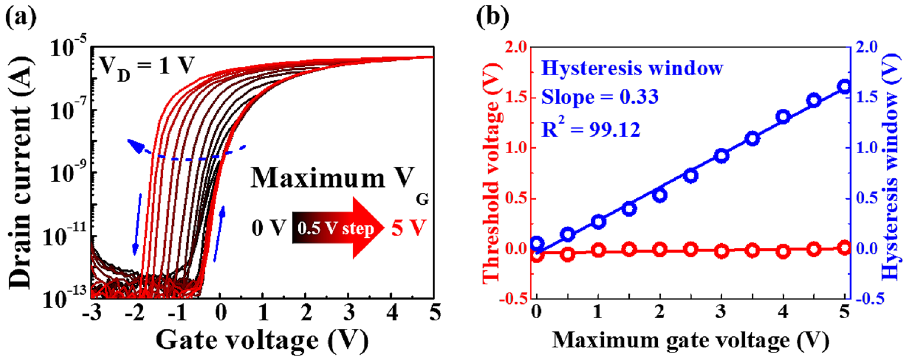
Figure 6. ( a ) Transfer characteristic curves of the chitosan electrolyte-Ta 2 O 5 hybrid EDLT according to the V G sweep range. Maximum V G = 0 to 5 V, in 0.5 V increments. ( b ) Dependence of the hysteresis window and the V th on the maximum V G